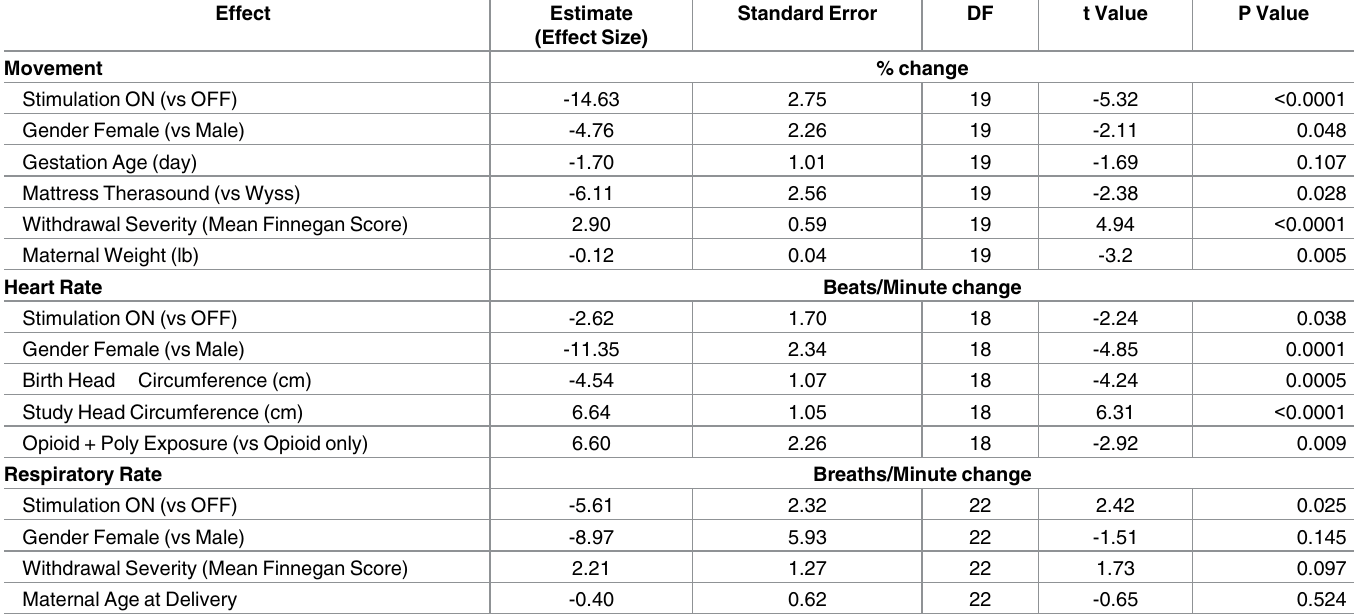
Table 3. Estimatesof fixed effectsfor movement, heart rate, and